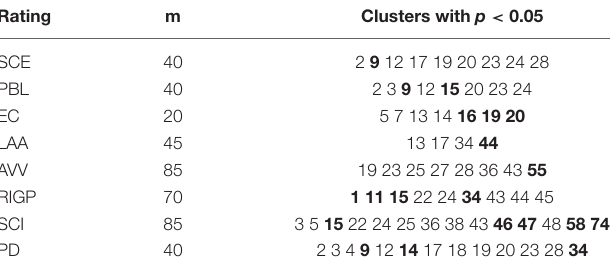
TABLE 8 | Statistically significant clusters of audio segments for each rating/skill, where the bold cluster number has the higher value for good presenters, and the remaining cluster numbers have higher value for bad presenters.